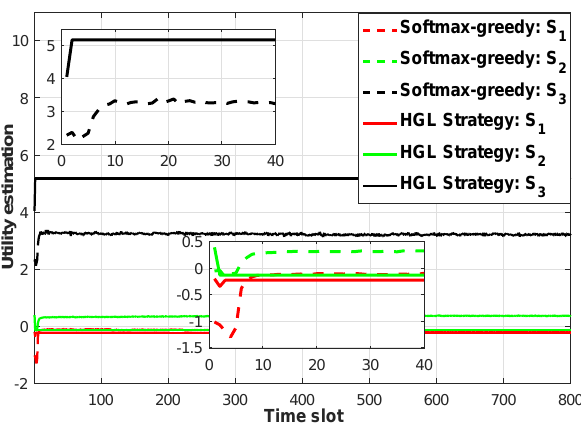
Figure 5. Convergence comparison between softmax-greedy and